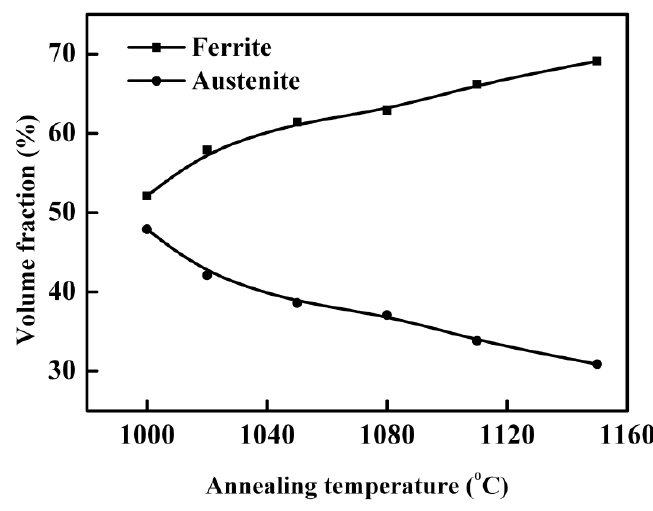
Figure 3. Volume fraction of ferrite and austenite phase with different annealing temperatures for 30